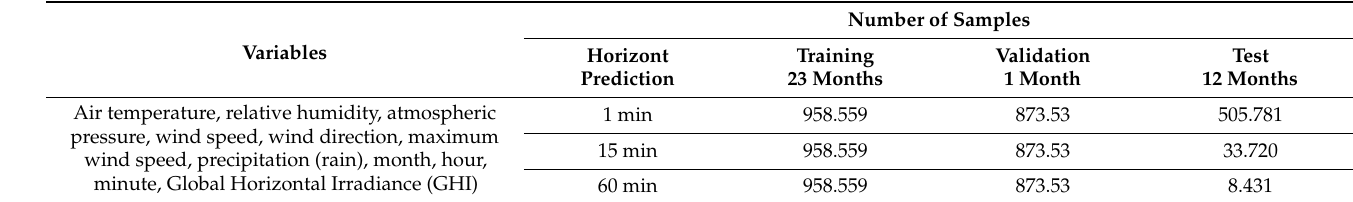
Table 2. Folsom dataset variables and details used in this study.